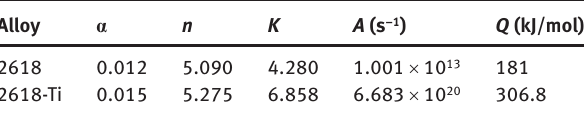
Table 3: Values of constitutive constants α , n , K , A and Q of alloy 2618 and 2618-Ti